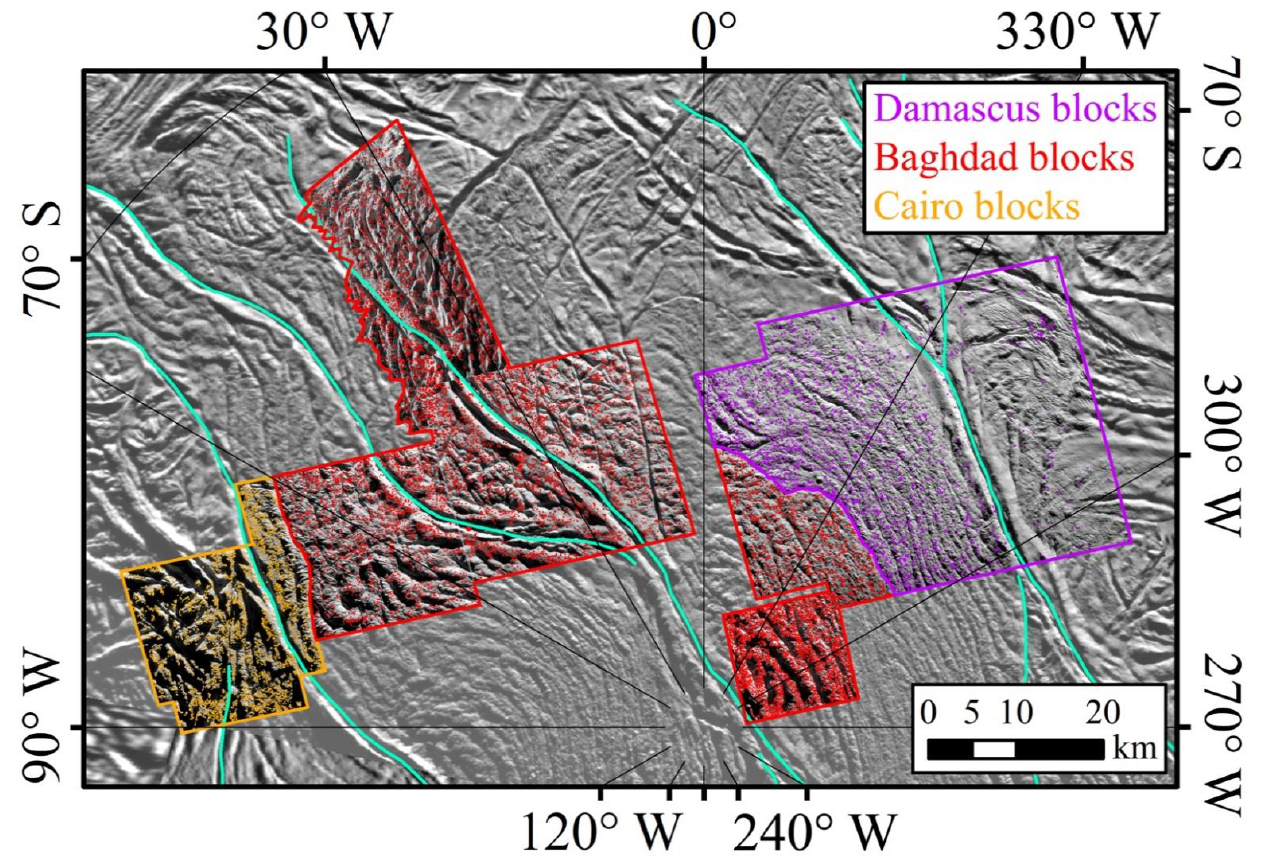
Figure 7. The division of the study area into three different groups: the Damascus, Baghdad and Cairo blocks.